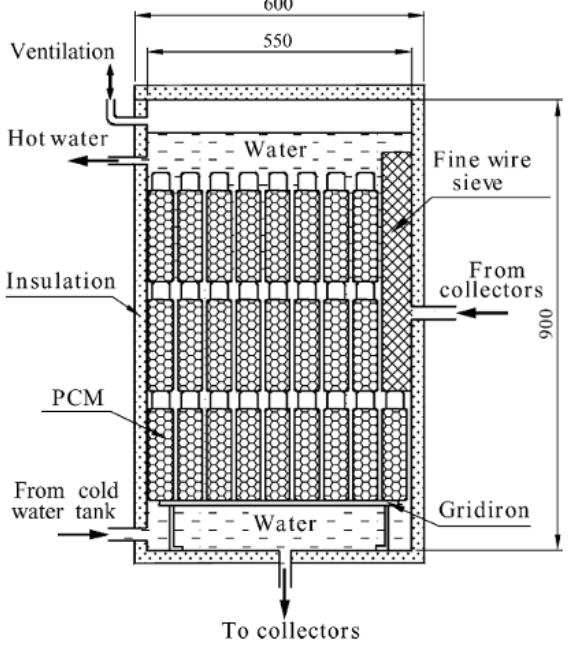
Figure 7. The PCM modules placed inside the hot water storage tank [25].